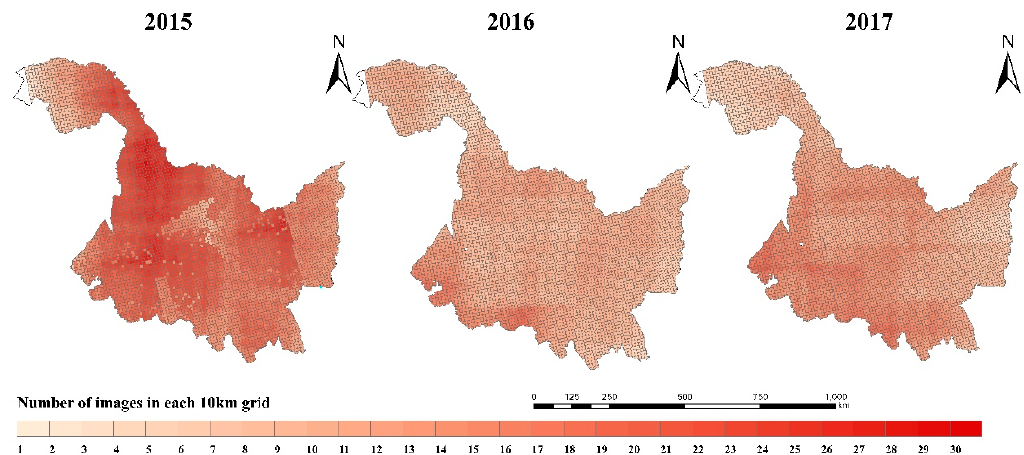
Figure 5. Heilongjiang Province 2015–2017, three-year time series distribution map, including the number of scene images for each 10 km grid.